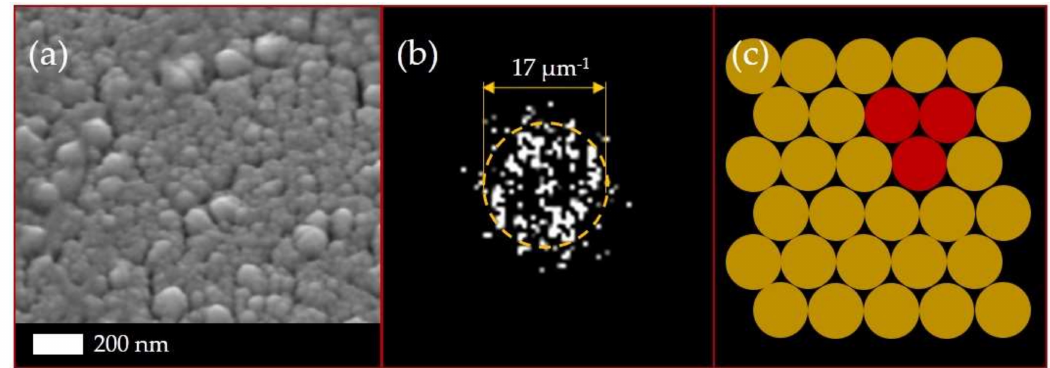
Figure 3. ( a ) The SEM top-view image of the gold film and ( b ) its fast Fourier transform (FFT) spectrum. The ring-pattern radius corresponds to the average distances between the structure elements (nanorods). ( c ) Schematic illustration of oligomeric structure. The building block in the form of a trimer is